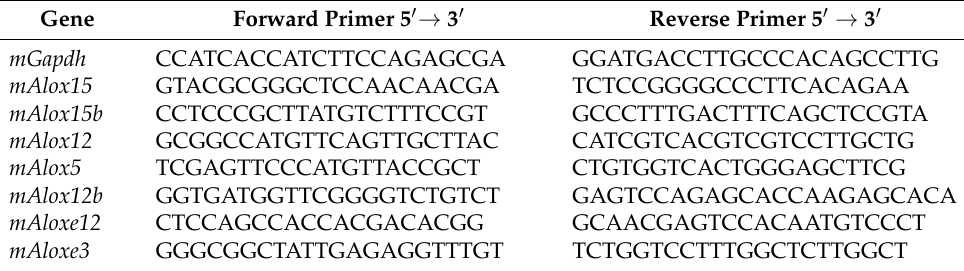
Table 2. Sequence of the gene specific amplification primers used for qRT-PCR.